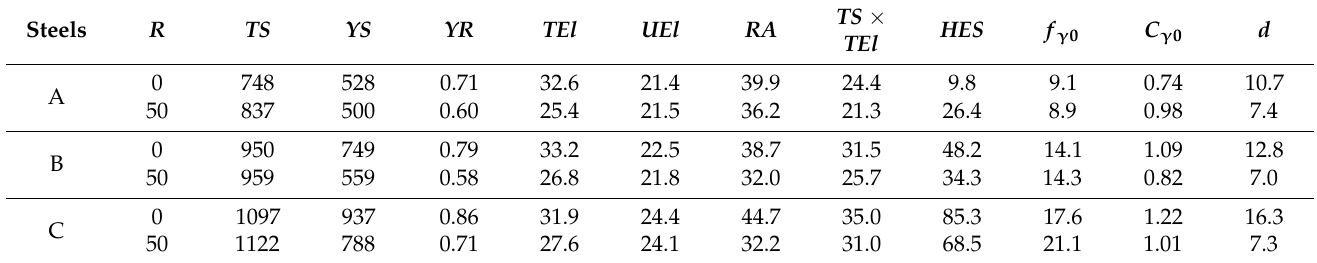
Figure 2. ( a , c , e , g , i , k ) Inverse pole figure (IPF) and ( b , d , f , h , j , l ) phase maps of steels ( a , b , g , h ) A, ( c , d , i , j ) B, and ( e , f , k , l ) C ( a – f ) without and ( g – l ) with hot forging. R represents reduction ratio. BCC and FCC denote body-centered-cubic and face-centered-cubic, respectively. Table 2. Tensile properties, retained austenite characteristics, and prior austenitic grain sizes of steels A, B and